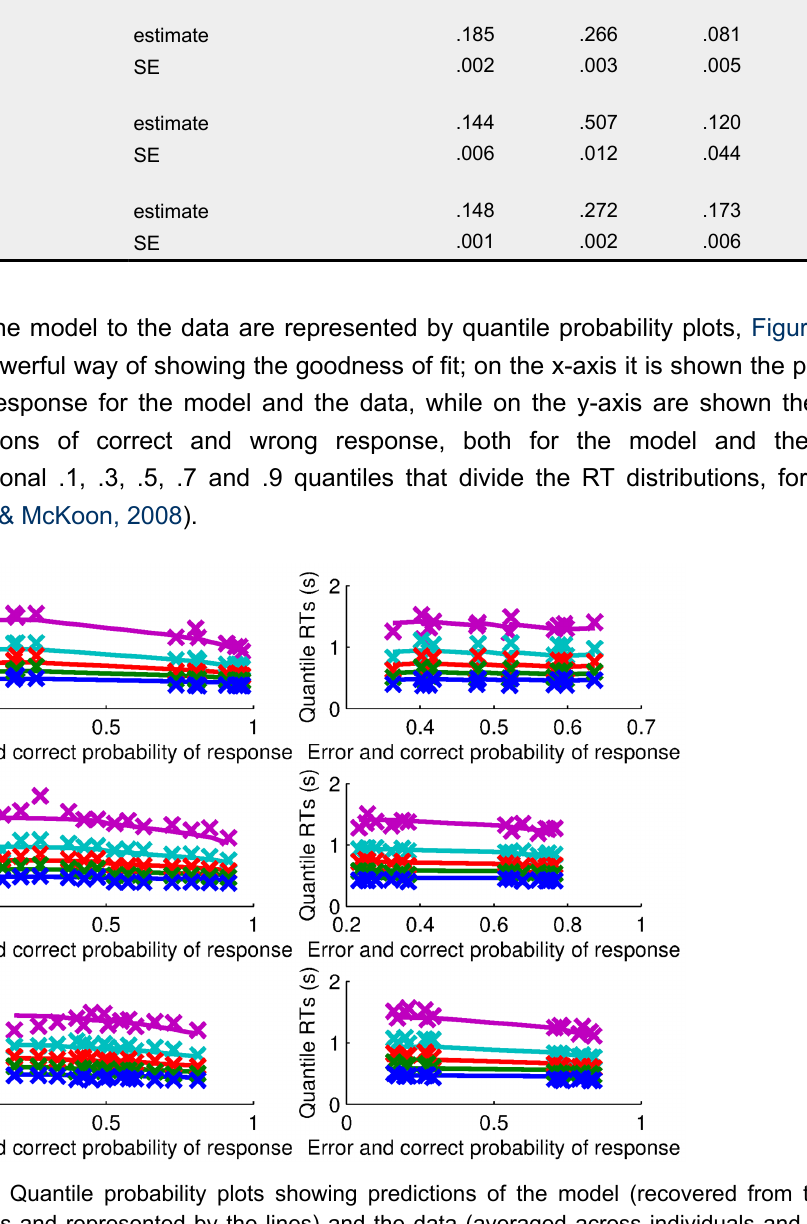
In Figure 6, we compare the predictions of the model based on the parameters averaged across individuals (represented by the lines), and the observed data pooled across individuals (represented by 'x'). Figure 6